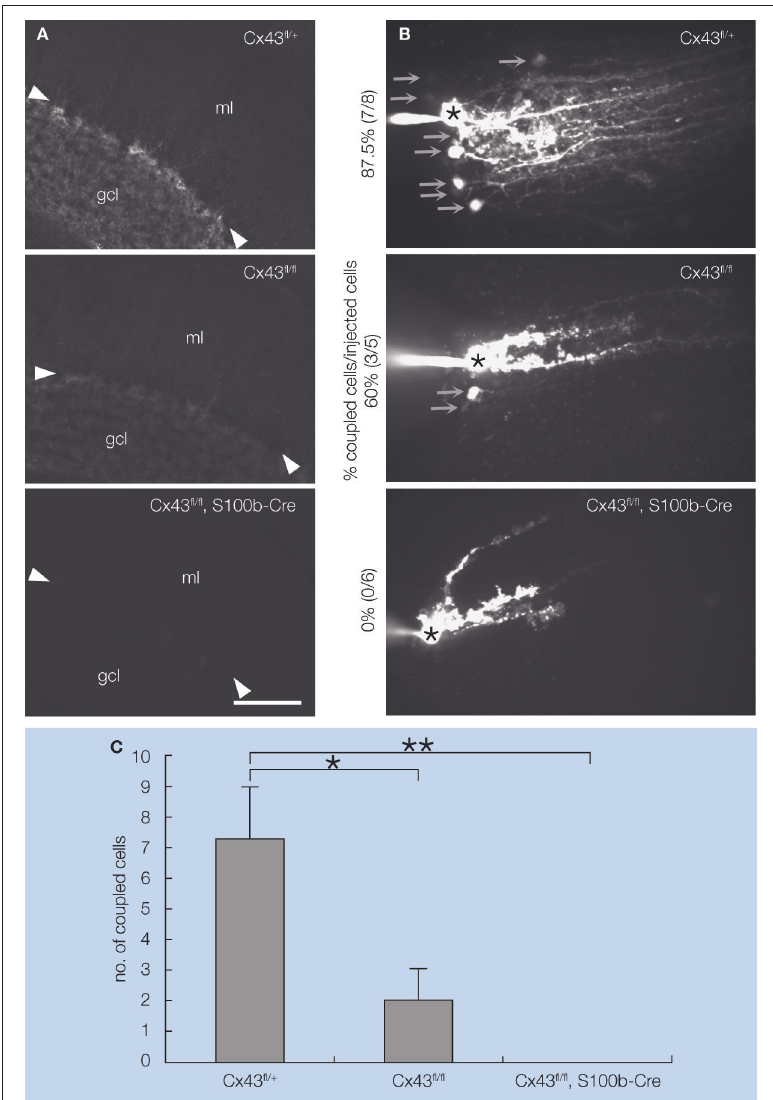
Figure 3 | Extent of S100b-Cre - mediated loss of Cx43 and Lucifer yellow coupling between BGC in Cx43 fl/ + , Cx43 fl/f l, and Cx43 fl/fl : S100b-Cre mice. (A) Immunofluorescence analysis of parasagittal sections of the cerebellum from Cx43 fl/ + , Cx43 fl/fl , and Cx43 fl/fl : S100b-Cre mice (2.5-month-old) using antibodies directed to Cx43. Arrowheads indicate Purkinje cell layer. gcl, granule cell layer; ml, molecular layer. Scale bar, 100 μ m. (B) Intercellular Lucifer yellow transfer in BGC in parasagittal cerebellar slices from Cx43 fl/ + , Cx43 fl/fl , and Cx43 fl/fl : S100b-Cre mice (3.5-month-old) after Lucifer yellow injection into one BGC soma. The asterisk indicates a dye-injected BGC cell body. Arrows indicate representative dye-coupled BGC cell bodies. (C) Average numbers of dye-stained neighboring cells when processes of injected cells were stained as shown in (B) ( n = 8 for Cx43 fl/ + , n = 5 for Cx43 fl/fl , and n = 6 for Cx43 fl/fl : S100b-Cre ). Error bars represent SEM. *, p < 0.05; **, p < 0.01 in ANOVA. Modified and reproduced from Tanaka et al. (2008). Front. Behav. Neurosci. 2,